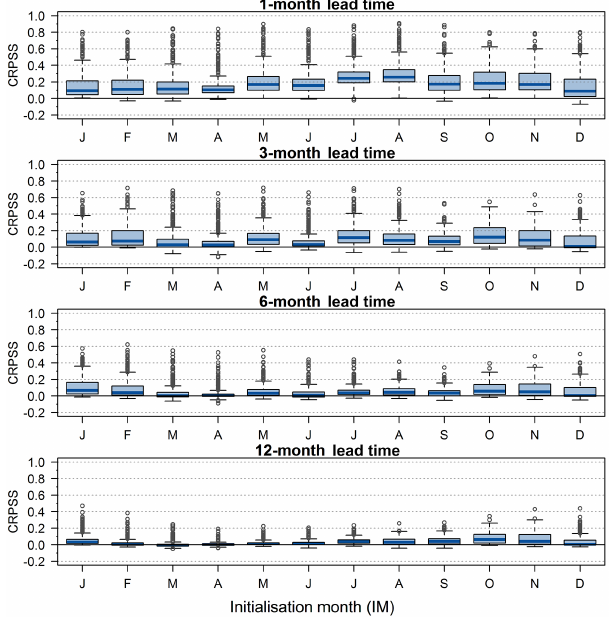
Figure 5. As in Fig. 4 but for the four monthly, seasonal, and annual lead